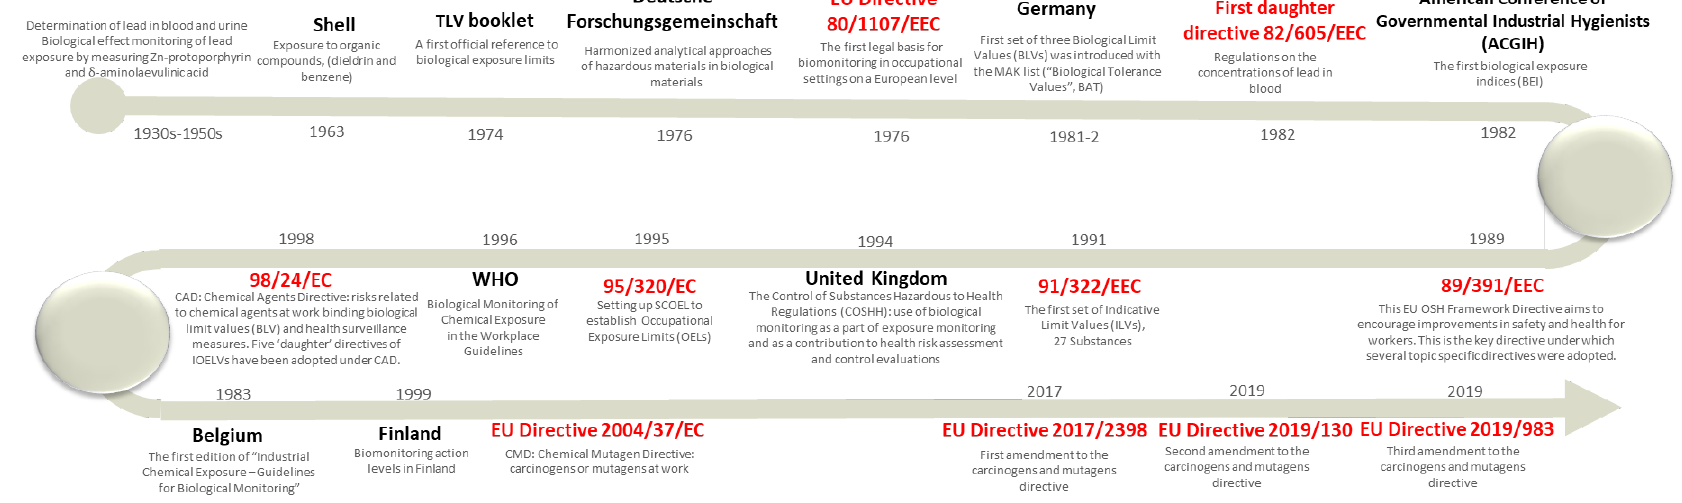
ffi cial implementation of biomonitoring (BM) in Figure 1. Sequence of steps towards an official implementation of biomonitoring (BM) in Europe. Figure 1. Sequence of steps towards an o